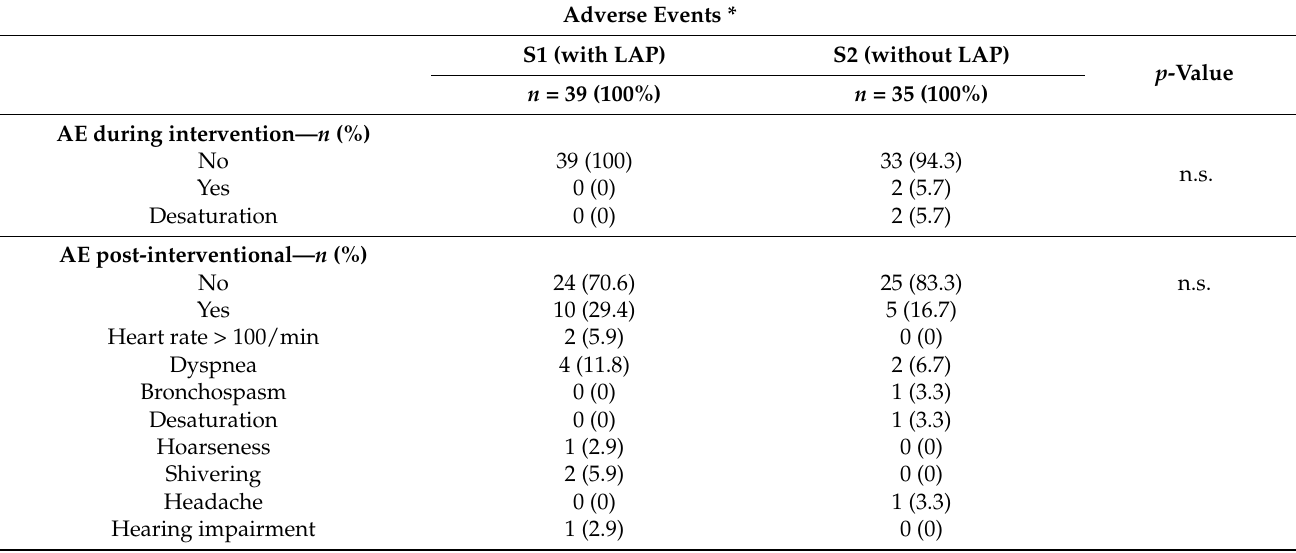
Table A3. Adverse events (AEs) during and after the intervention with subspecification of the observed